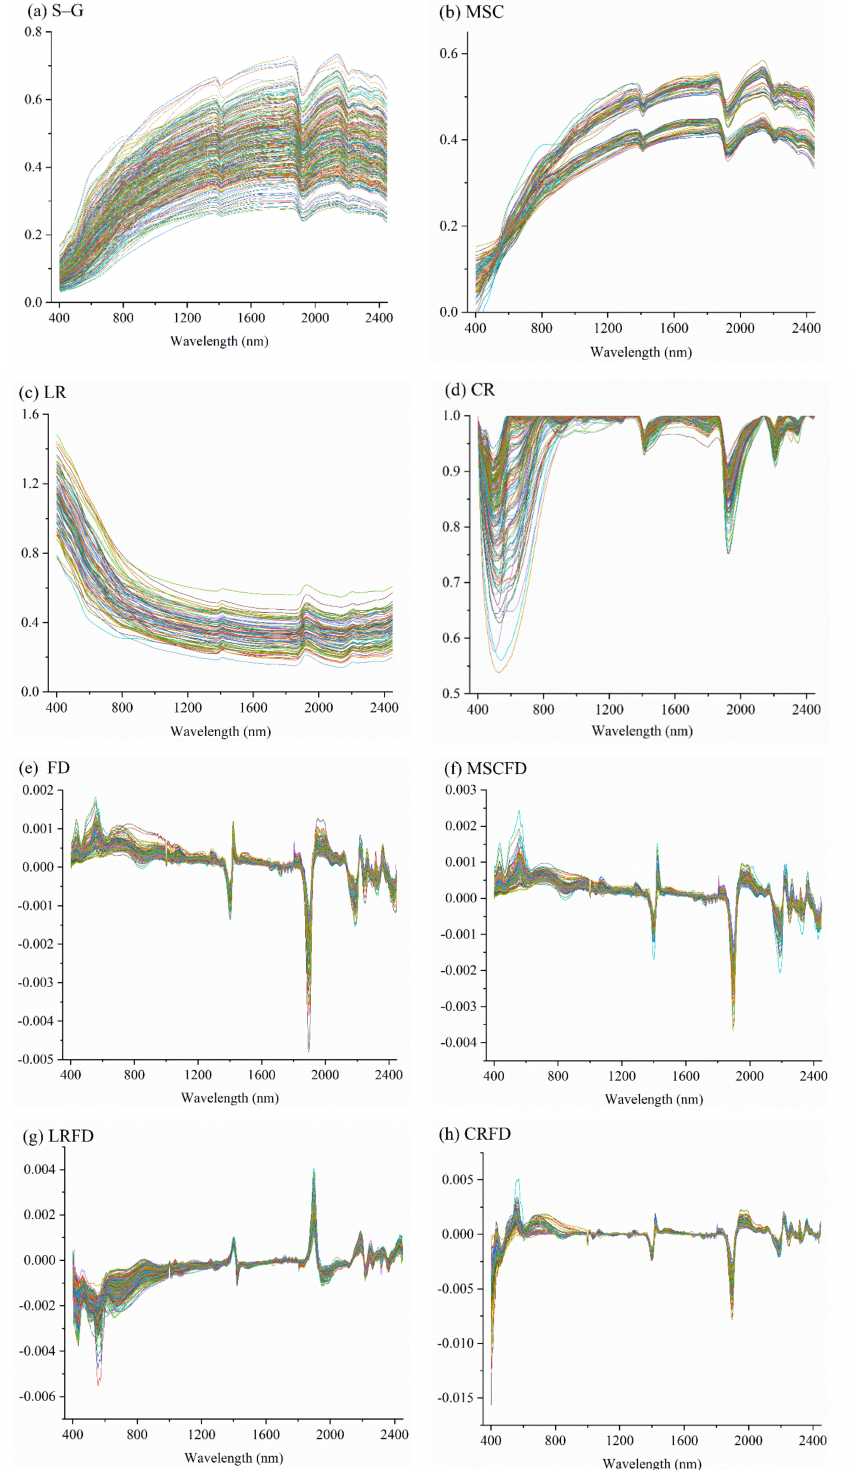
Figure 2. Soil spectral curve of eight kinds of spectral transformations. ( a ) Savitzky–Golay smooth filtering, ( b ) multivariate scattering correction, ( c ) logarithmic reciprocal, ( d ) continuum removal, ( d , e ) first–order differential, and ( f – h ) first–order differential transformation based on ( b – d ), respec- tively). The color lines represented the spectral curve of soil